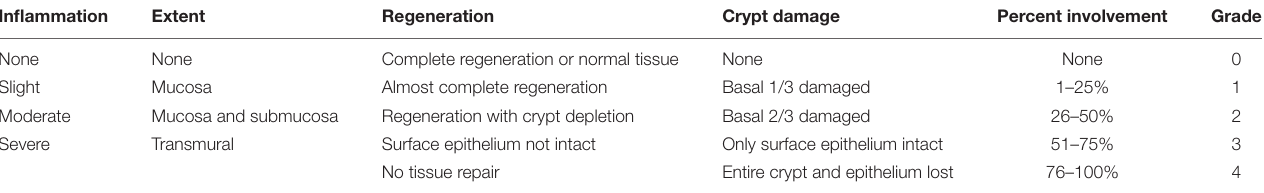
TABLE 1 | Histological grading of colitis.